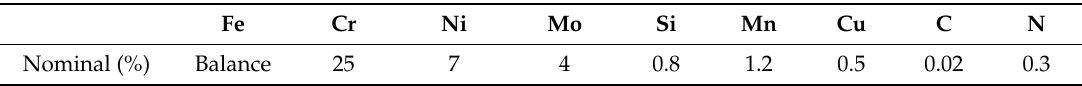
Table 1. Chemical composition of the sample material (SAF 2507 type super-duplex stainless steel